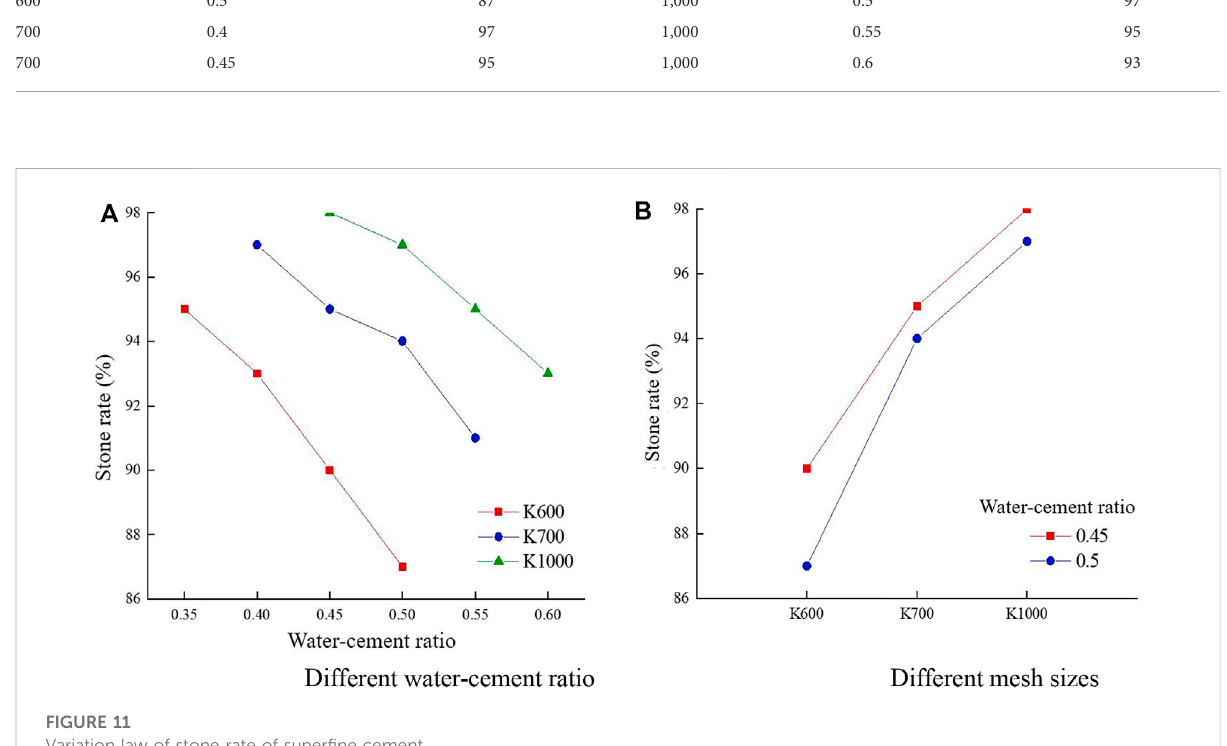
FIGURE 11 Variation law of stone rate of super fi ne cement.